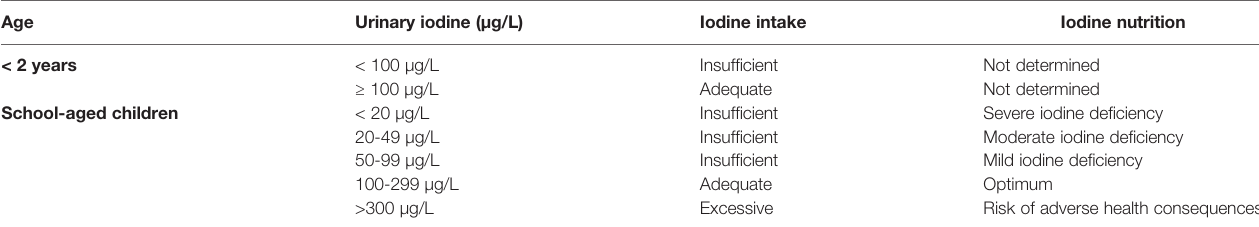
TABLE 1 | Urinary iodine concentration in infants and children, according to World Health Organization.